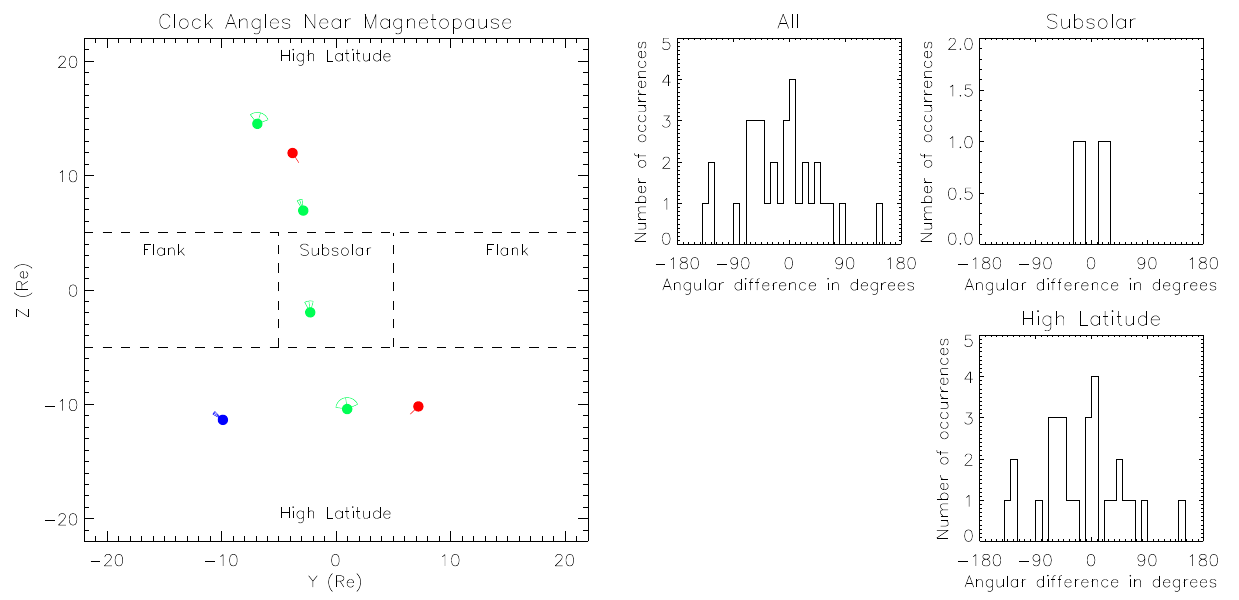
Fig. 14. Clock angles measured near magnetopause, and angular differences from perfect draping, for low solar wind dynamic pressure and Northward IMF. Format as Fig.